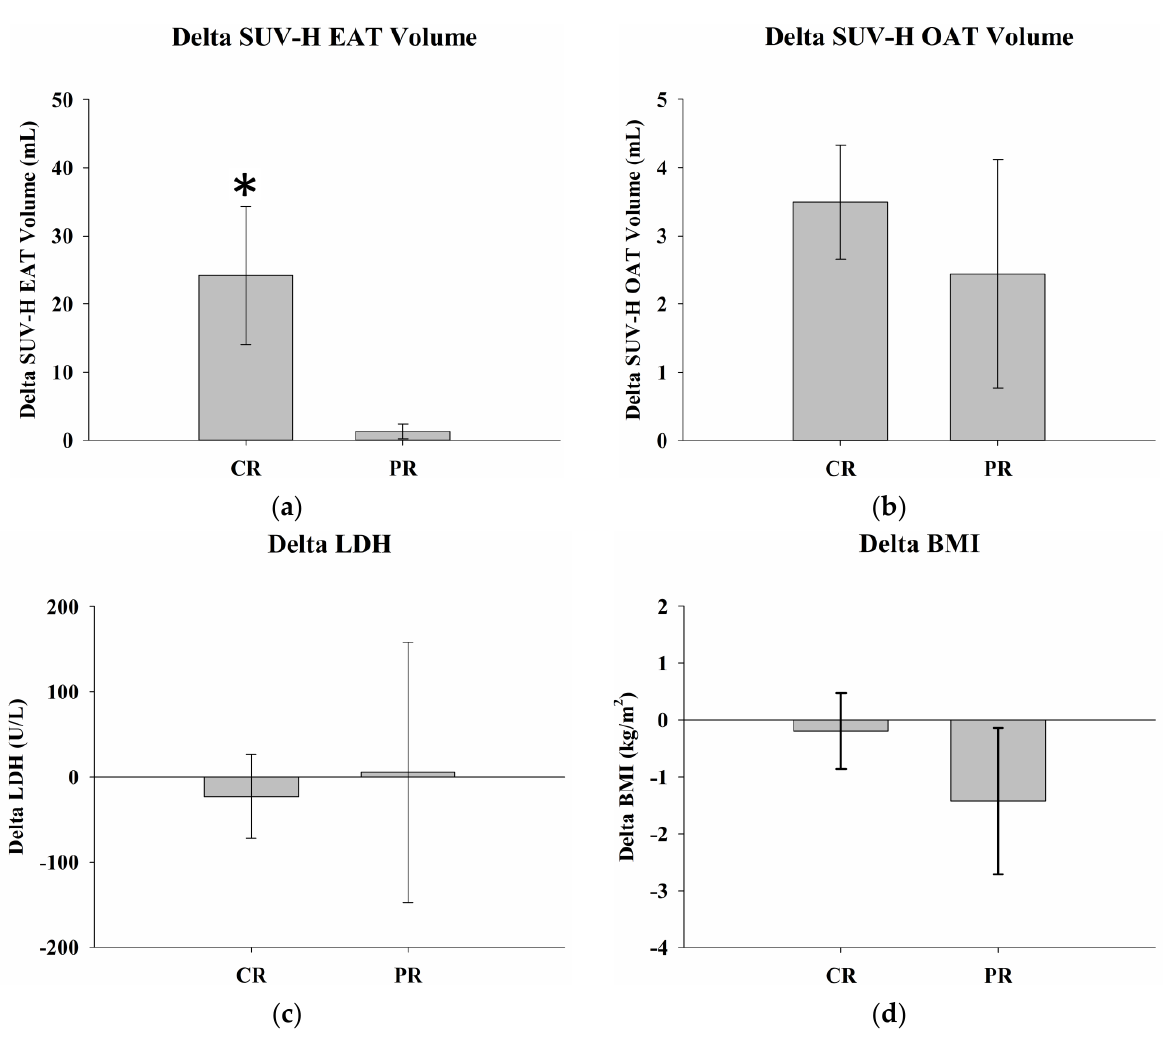
Figure 6. Delta SUV-H EAT and SUV-H OAT volumes, serum LDH levels, and BMI in complete and partial responders. ( a ) Greater delta SUV-H EAT volume was observed in complete responders than in partial responders ( p = 0.04). ( b – d ) There were no statistically significant differences in the delta SUV-H OAT volume, serum LDH levels, or BMI between complete and partial responders, with p values of 0.55, 0.84, and 0.37, respectively. * Differences are significant at the 0.05 level (two-tailed). SUV-H EAT, high standardized uptake value epicardial adipose tissue; SUV-H OAT, high standardized uptake value orbital adipose tissue; LDH, lactate dehydrogenase; BMI, body mass index; CR, complete response; PR, partial response.